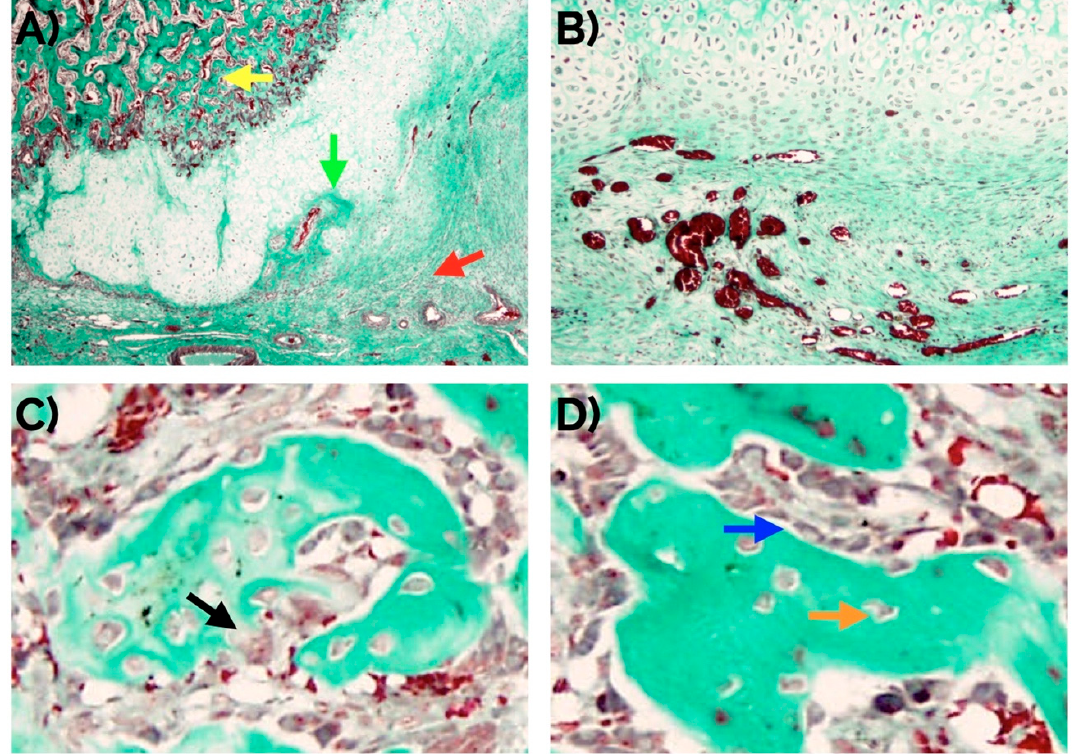
Figure 2. ( A ) Histomorphological confirmation after 14 days of an effective endochondral and intramembranous repair around a bone fracture callus involving fibrocartilage (red arrow), cartilage (green arrow), and newly formed bone trabecula (yellow arrow). An adequate number of new vessels can be observed ( B ) as well as normal distribution of osteoclasts (arrow in ( C )), and osteocytes (orange arrow in ( D )), and osteoblasts (blue arrow in ( D )). Masson’s trichrome staining. Original magnification: 4× ( A ), 10× ( B ) and 40× ( C , D ).